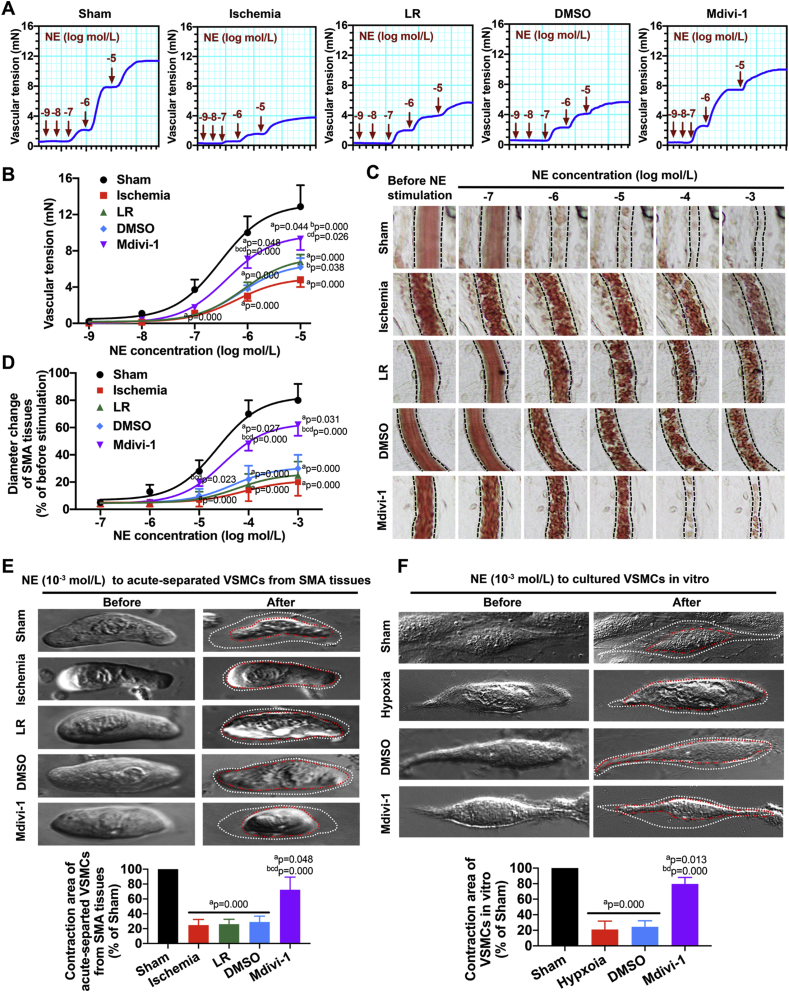
Effects of Mdivi-1 on vascular functions in ischemic/hypoxic injury. (A) Vascular tension curve of SMA to different concentrations of NE (10−9, 10−8, 10−7, 10−6 and 10−5 mol/L). (B) The statistics of vascular reactivity in SMA tissues to NE stimulation (n = 8 rats/group). (C) Alteration in SMA diameter to different concentrations of NE (10−7, 10−6, 10−5, 10−4 and 10−3 mol/L). The vascular boundaries were labeled in dotted line. (D) The statistics of diameter change in SMA to NE stimulation (n = 8 rats/group). (E–F) The contractility of acute-separated VSMCs (E, n = 8 rats/group) and cultured VSMCs (F, n = 16 cells/group) to 10−3 mol/L NE stimulation. The cell boundaries before NE stimulation were labeled in white dotted curve and the cell boundaries after NE stimulation were labeled in red dotted curve. The range of contraction areas in VSMCs were measured by Image J software. a: P < 0.05 compared with the Sham group at the same time point, b: P < 0.05 compared with the Ischemia group at the same time point, c: P < 0.05 compared with the LR group at the same time point, d: P < 0.05 compared with the DMSO group at the same time point. (For interpretation of the references to colour in this figure legend, the reader is referred to the Web version of this article.)